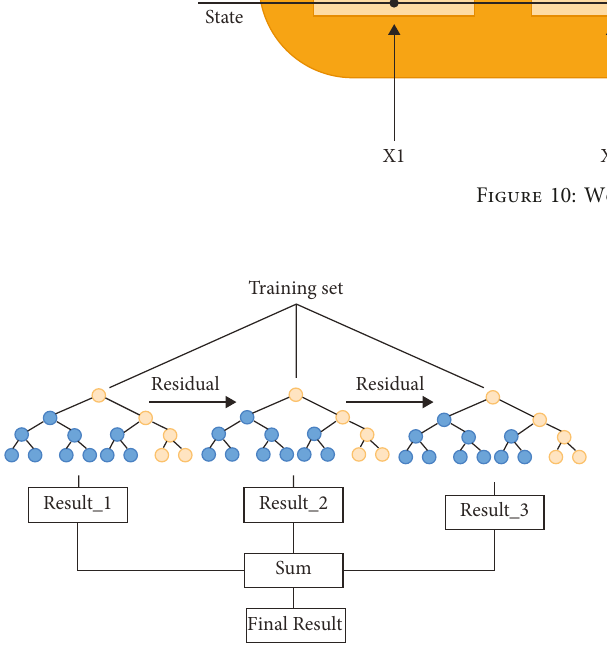
Figure 11: XGBoost